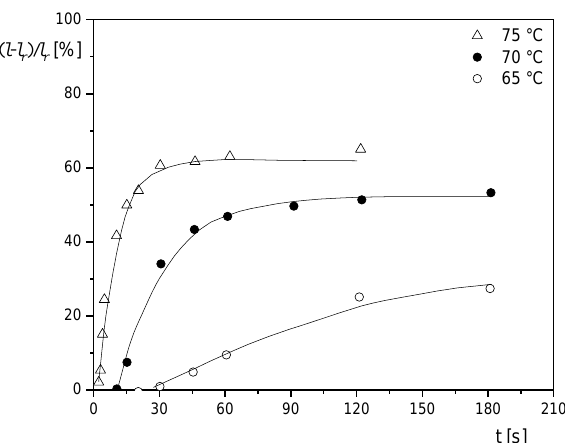
Figure 8. Shrinkage ( l − l r ) / l r as a function of annealing time t at various temperatures for an extruded film from a polyethyleneterephthalate / glycol copolymer (PETG) uniaxially prestretched at 85 ◦ C by a factor 3 before cooling. The full lines represent single exponential functions, according to [18].